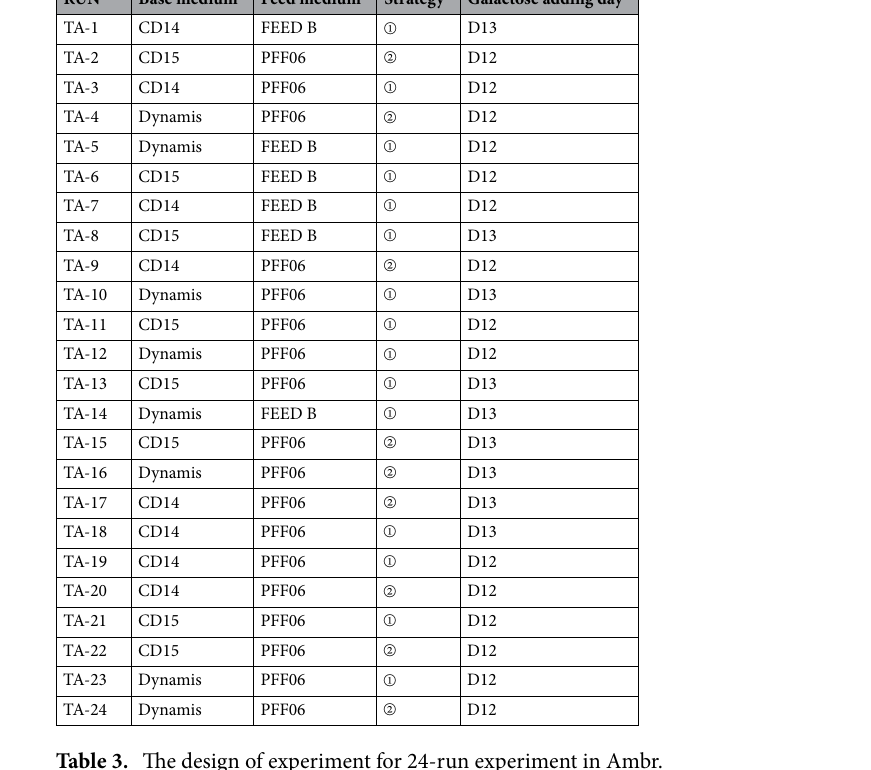
Cell culture condition and experimental design. The candidate cell line was cultured in Dynamis in clone screening phase. To test the new medium, the cells were cultured in CD14 and CD15 for 3 passages to allow the cell to adapt to the new medium. The fed-batch culture mode was applied in AMBR with temperature, pH, DO and agitation controlled. The temperature was set at 37 °C on the beginning culture and shifted to 35 °C on day 4. DO was maintained at 50% and pH was in the range of 6.8–7.2. The seeding density was 1 million cells/ mL with 12 mL initial culture volume. Two feeding strategies was tested in the experiment. For strategy 1, feed- ing started from day 3 and the feeding volume was calculated through Eq. (1). For strategy 2, feeding volume was 4% of the initial volume on day 3 and 6% of the initial volume every other day till the harvest day. The glucose residual concentration was tested every day and glucose was supplemented to 3 g/L when viable cell density (VCD) was less than 10 million cells/mL and to 4 g/L otherwise. The feeding volume of glucose was calculated through Eq. (2). The base medium, feed medium, feeding strategy and the galactose addition day were designed by custom DoE function as four factors using JMP. 24 runs of experiment were conducted according to the design (Table 3). All the runs were harvested on day 14.